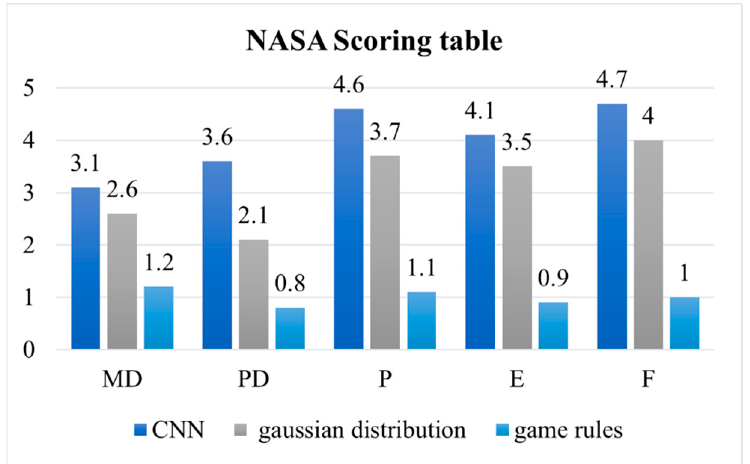
Figure 13. NASA user evaluation.